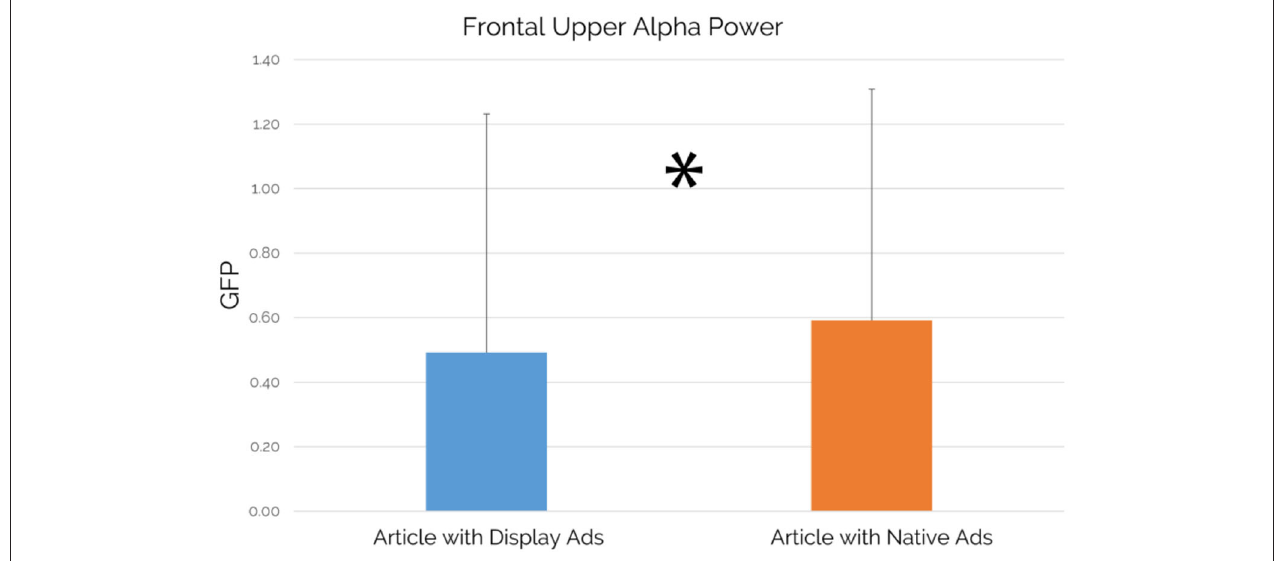
FIGURE 7 | Frontal Upper Alpha Power: comparison between an article containing display ads and an article containing native ads ( n = 49). An article containing native ads showed a statistically significant increase in Frontal Upper Alpha Power values in comparison to an article containing display ads ( p = 0.047, d = 0.3). Error bars represent standard deviation.